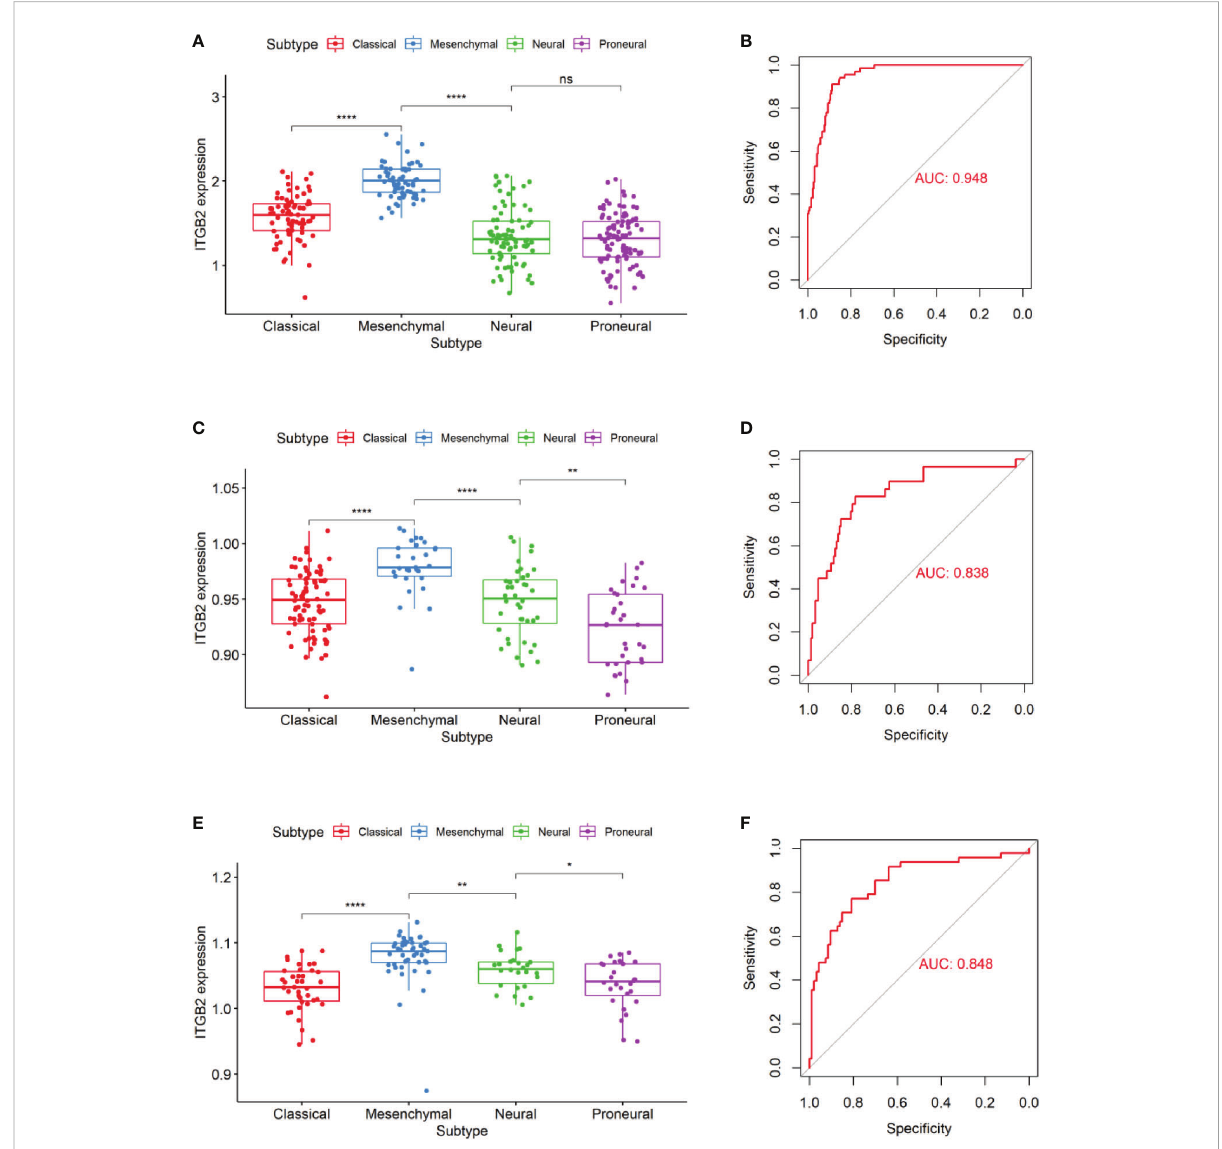
(F) datasets. ns, no signi fi cant differences; *p < 0.05, **p < 0.01, ****p <